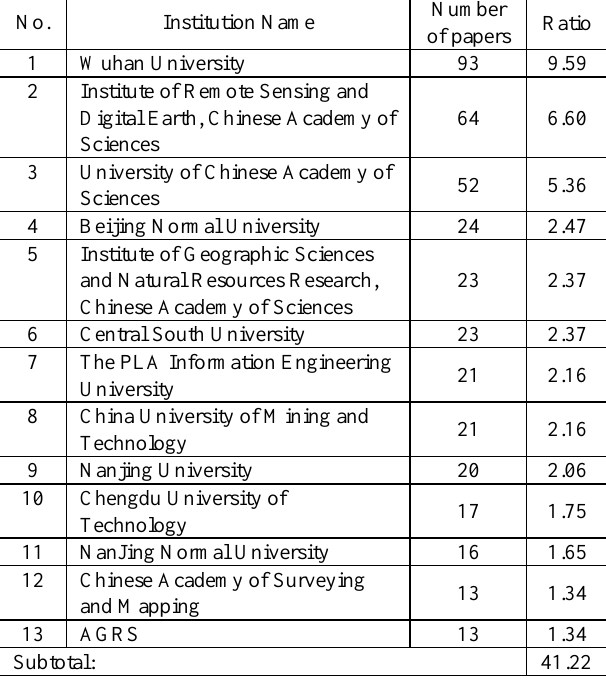
Table 3. Institutions of highly cited papers from 2010 to